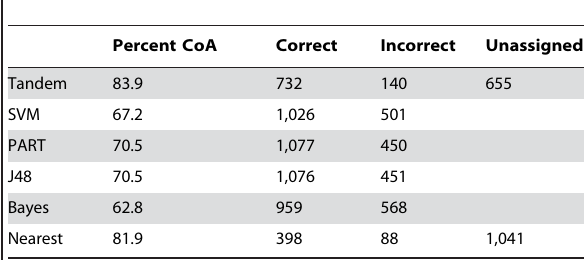
Table 4. Classification results for the 9-locus public Y-STR data.